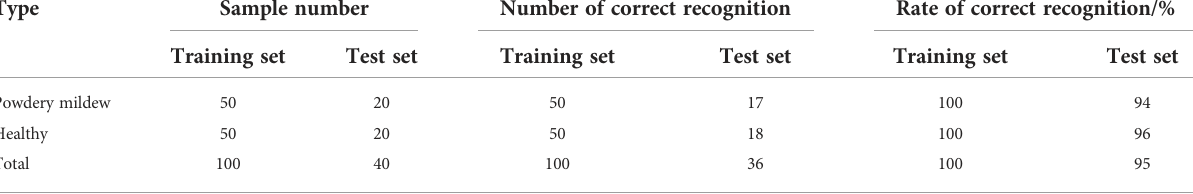
TABLE 4 Recognition results of cucumber powdery mildew (visible light).